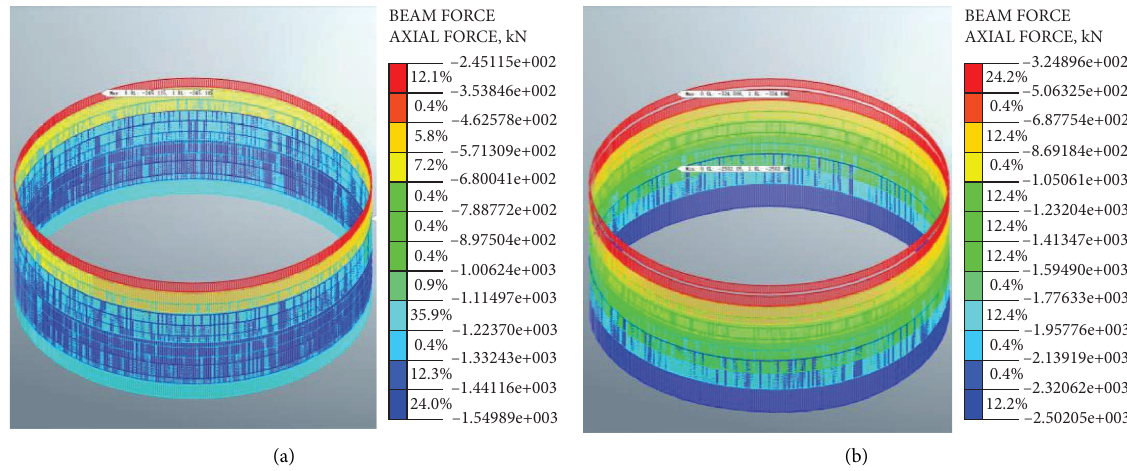
Figure 36: Working condition 9 lining axial force (a) without pore water pressure and (b) with pore water pressure applied.